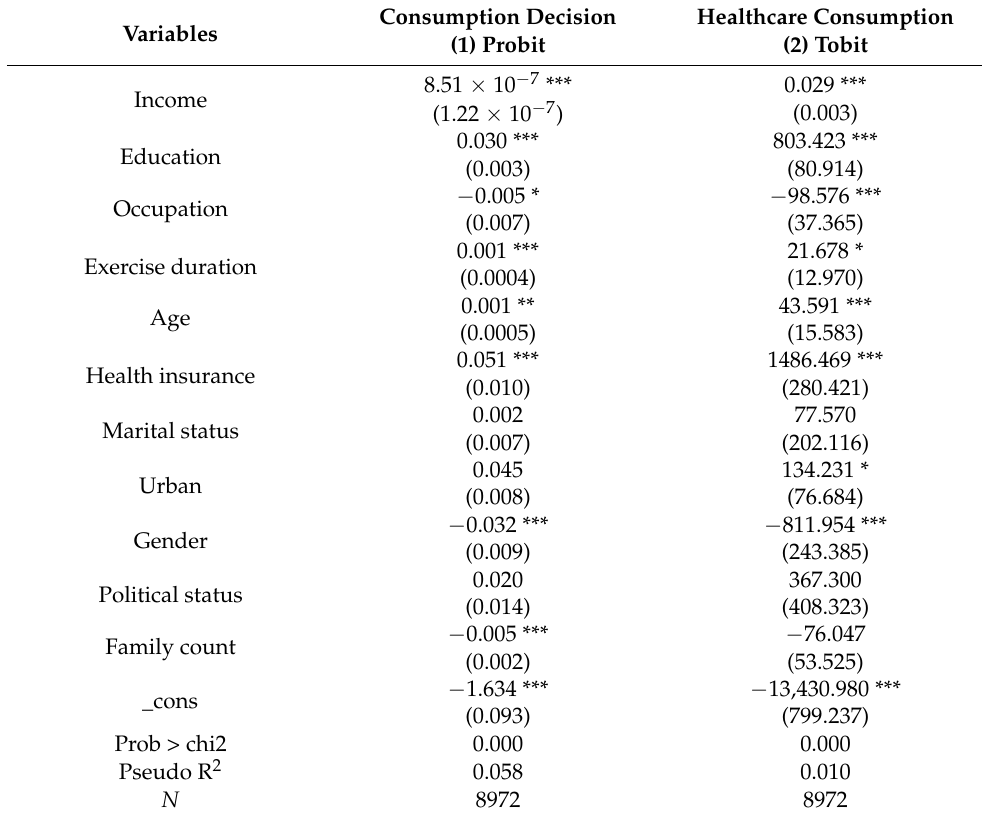
Table 4. Mediating effect results from residents’ physical exercise